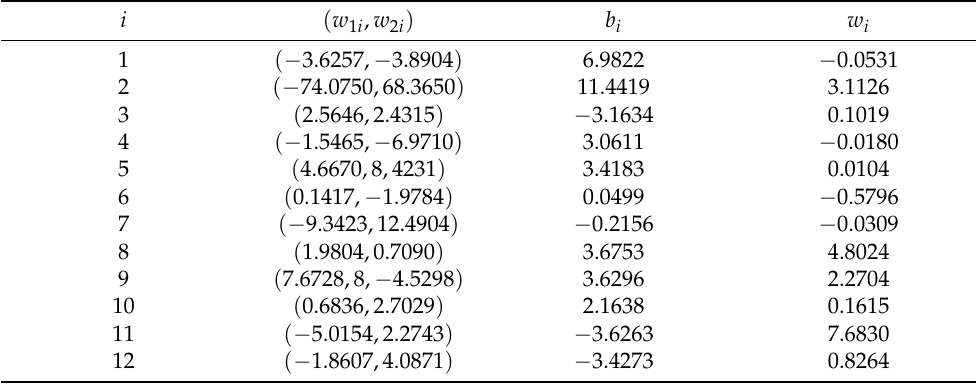
Figure 7. Simulation of the wiping-out property. ( a ) Input signal. ( b ) Hysteresis trajectory. Table 1. Parameters of the back propagation neural